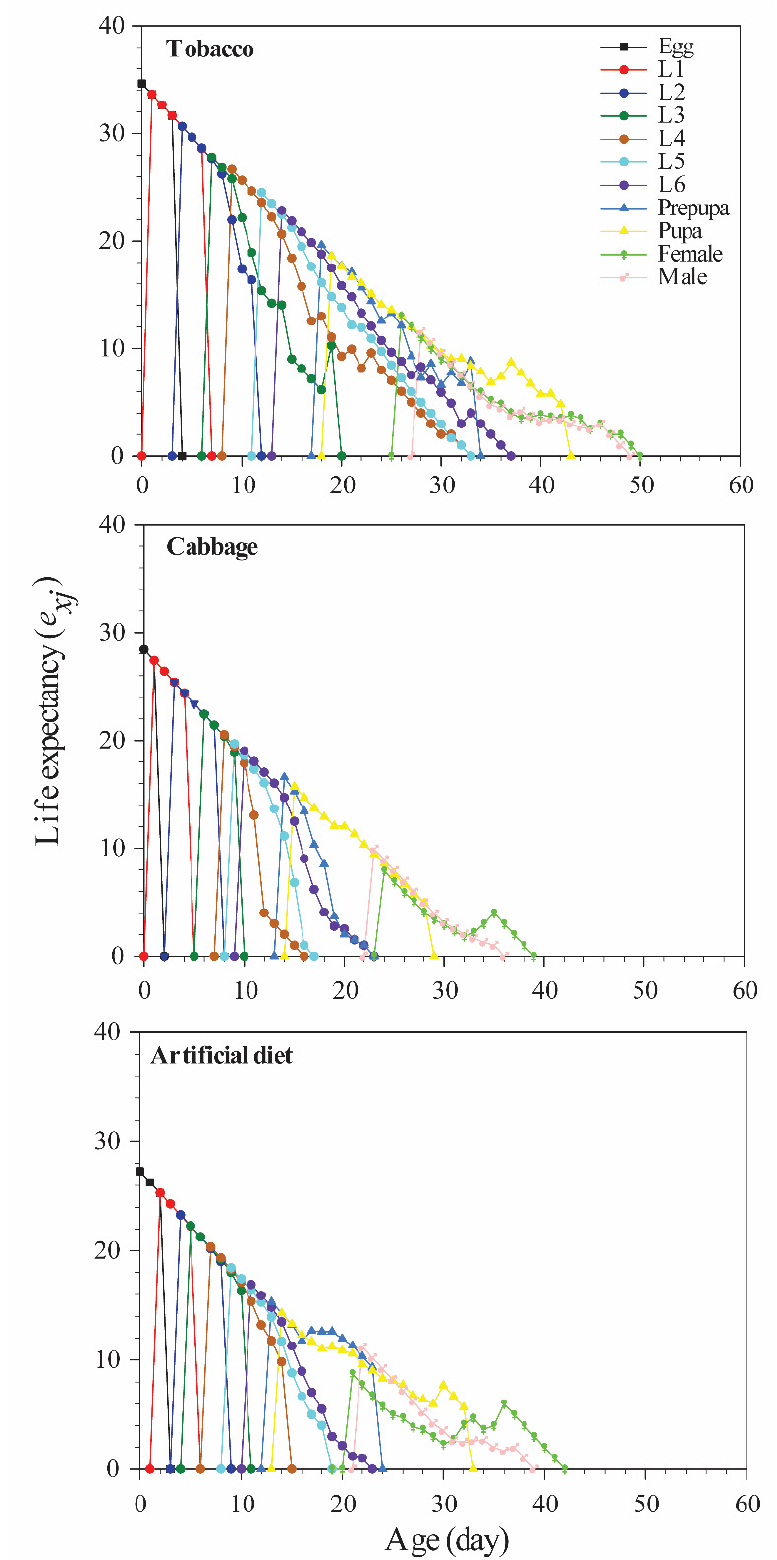
Figure 3. Age-specific life expectancy ( e xj ) of Spodoptera litura reared on different diets.